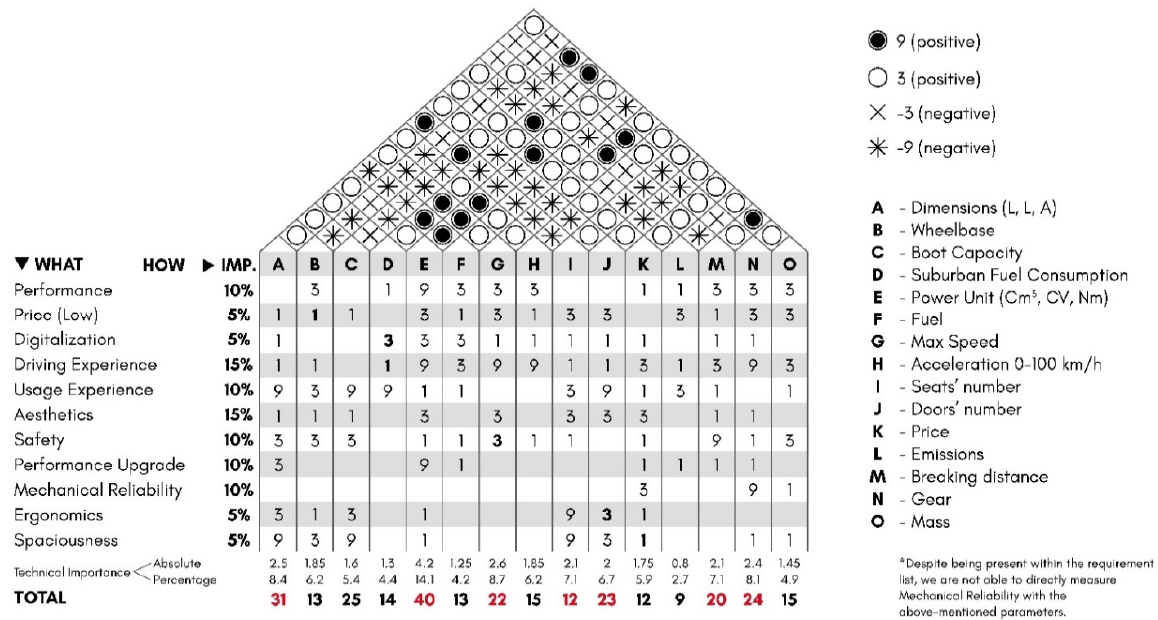
Figure 10. Visual representation of Top-Flop Delta for each vehicle.